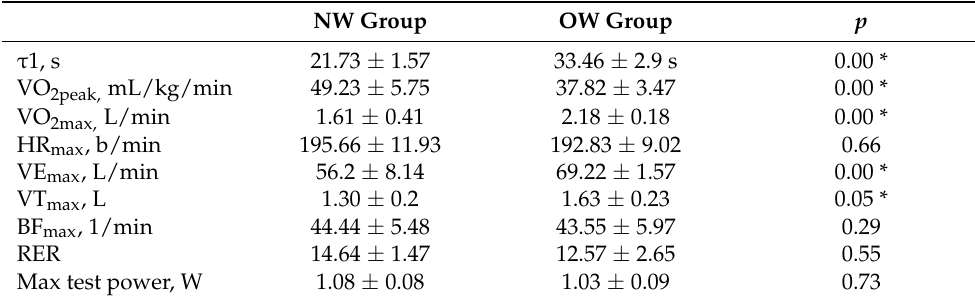
Table 3. Parameters of walking exercise among 6–12 years old NW and OW children.